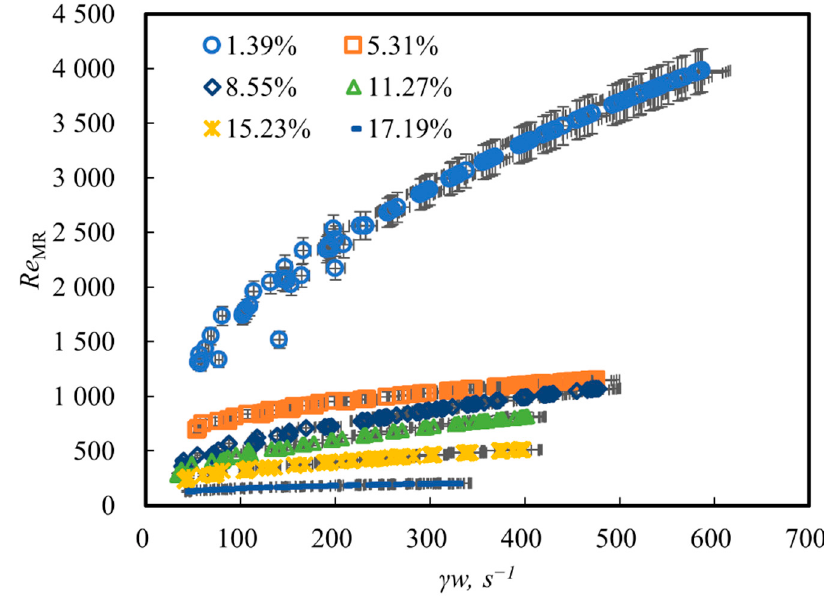
Figure 10. Reynold numbers along shear rate under different hydrate concentration conditions.